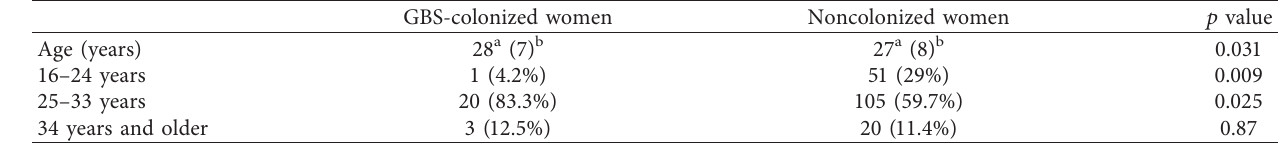
Table 2: Age groups of GBS-colonized and noncolonized women.